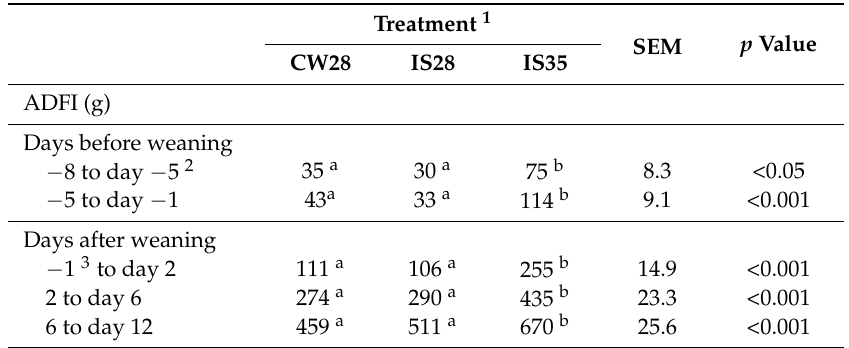
Table 2. Effect of intermittent suckling with and without an older weaning age on the average daily feed intake of piglets before and after weaning.